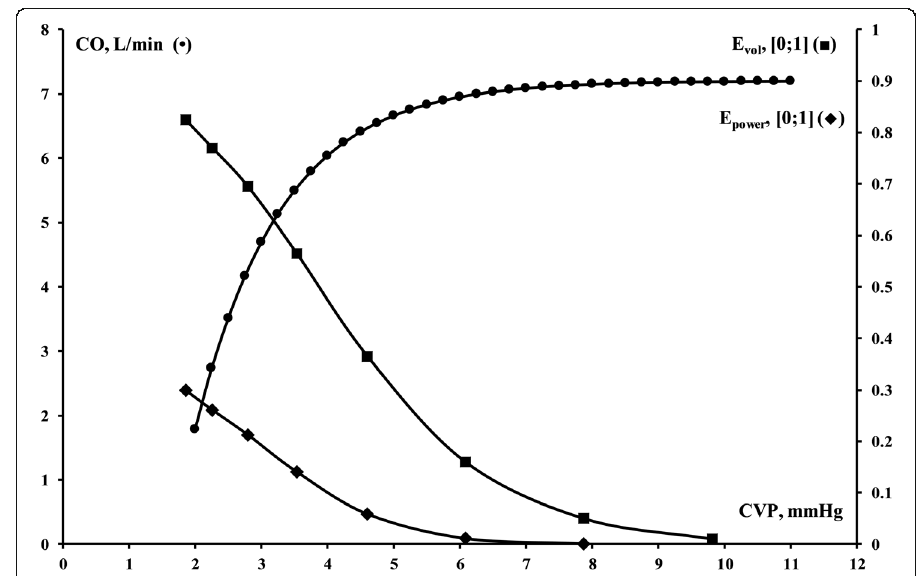
Fig. 2 Concordant cardiac function curve (filled circle), volume efficiency (filled square) and power efficiency (filled diamond) as P